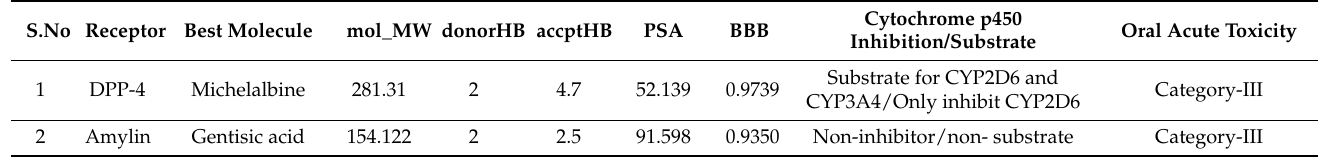
Table 1. ADMET results for the top molecules.